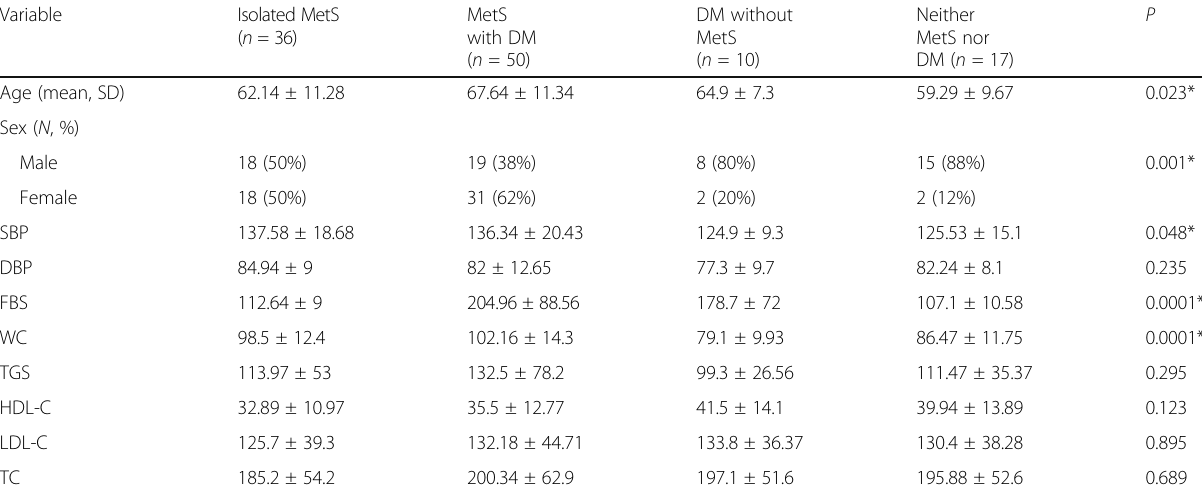
Table 1 Sociodemographic, laboratory, and clinical characteristics of studied groups Variable